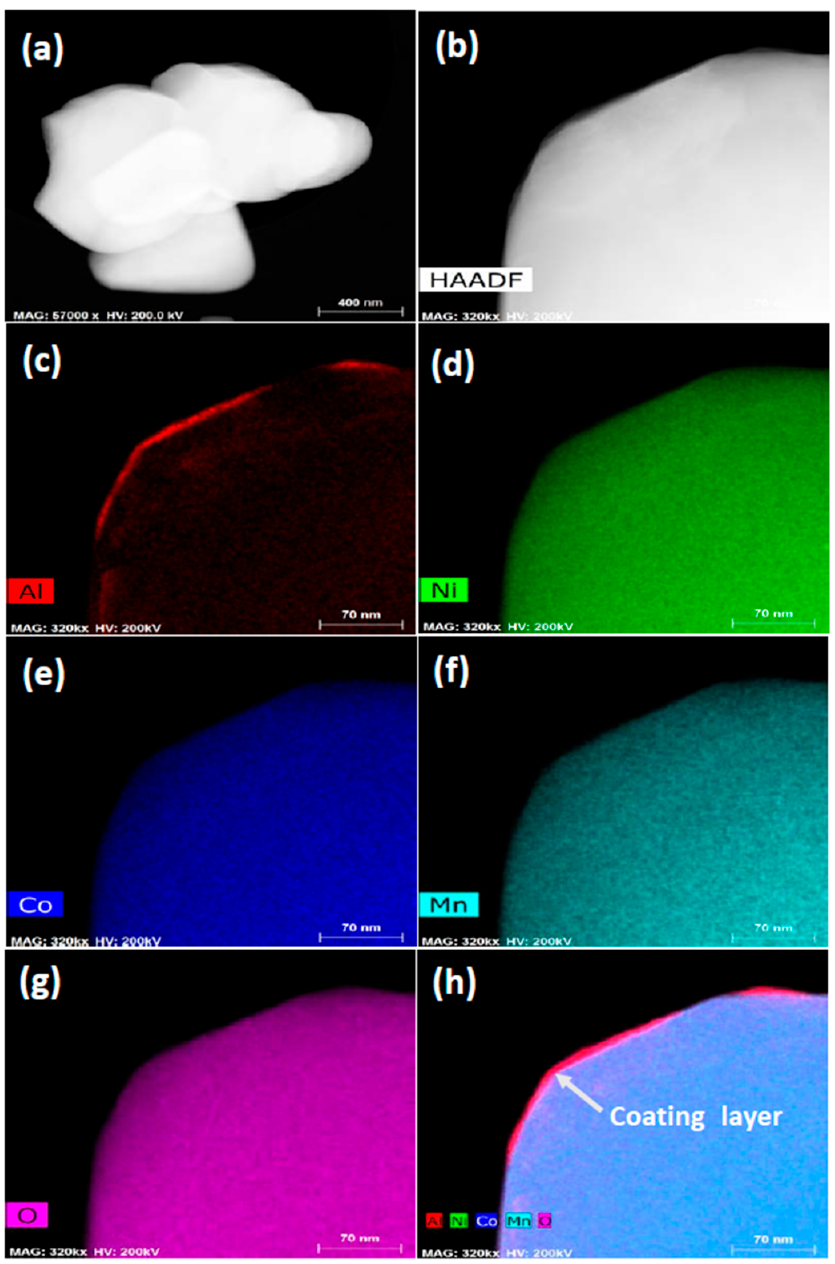
Figure 5. ( a , b ) Images of the EDS mapping region; and ( c – h ) the elemental mappings of the 0.08 wt % Al 2 O 3 -coated Li(Ni 0.6 Co 0.2 Mn 0.2 )O 2 sample annealed at 600 °C for 4